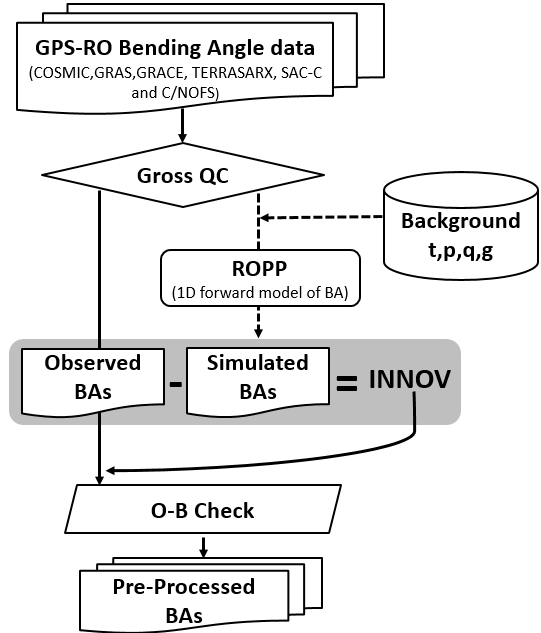
Figure 1. Schematic diagram of the GPS-RO data processing sys- tem implemented in